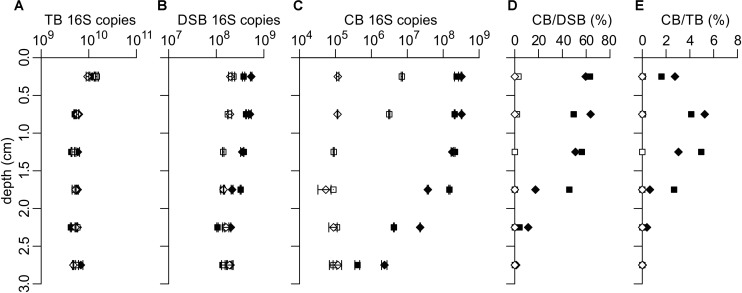
qPCR quantification of 16S rRNA gene copies of (A) total bacteria (TB), (B)
Desulfobulbaceae (DSB) and (C) cable bacteria (CB). (D) CB 16S copies relative to DSB 16S copies and (E) CB 16S copies relative to TB 16S copies. Data is for two replicate cores each from unamended incubations (open symbols) and stimulated incubations (filled symbols). Data in panels (A–C) shows the mean with error bars denoting the standard deviation (n = 2). 16S rRNA gene copies are expressed per gram of wet sediment.